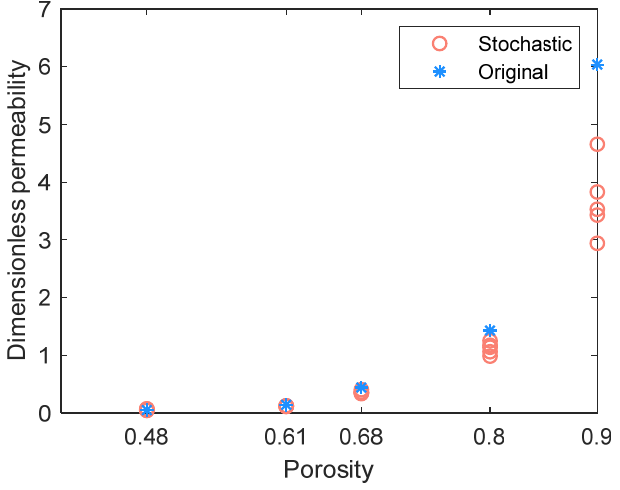
Figure 9. Figure 9. Dimensionless permeabilities in the in-plane direction of the original network and stochastic realizations. Five stochastic realizations are generated for each